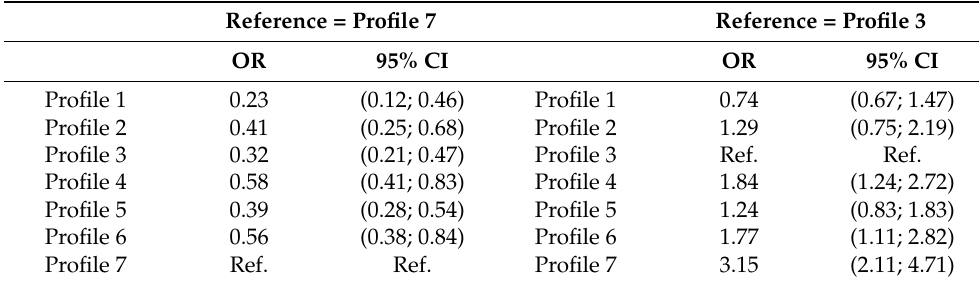
Table 5. Associations with continued chronic course of depression for each profile compared to two reference groups: the largest overall profile (Profile 7) and the profile with approximately equal numbers in remission and not in remission at 3 to 4 months (Profile 3).